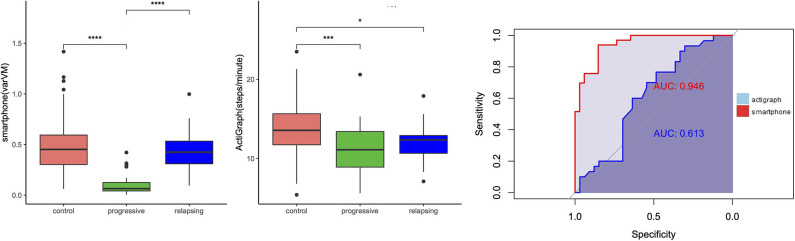
Group differences between relapsing–remitting and progressive multiple sclerosis (MS). Left: Boxplots showing smartphone and ActiGraph metrics for controls, progressive (or late) MS and relapsing (or early) MS. *p < 0.05, ***p < 0.001, ****p < 0.0001. Right: receiver operating characteristic (ROC) curves of smartphone (red) and ActiGraph (blue) showing the ability of differentiation between the MS groups.